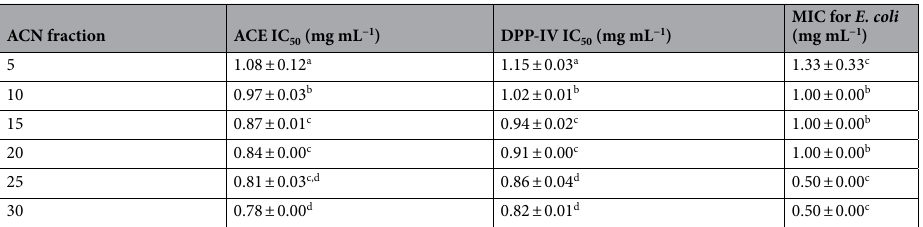
Table 4. Biological activities of gelatin hydrolysate fractions obtained by solid phase extraction. Data are shown as mean ± standard error of three replicates. Different superscript letters in the same column represent significant differences ( P < 0.05). ACE, angiotensin-converting enzyme; ACN, acetonitrile; DPP-IV, dipeptidyl peptidase IV; IC 50 , half maximal inhibitory concentration; MIC, minimum inhibitory